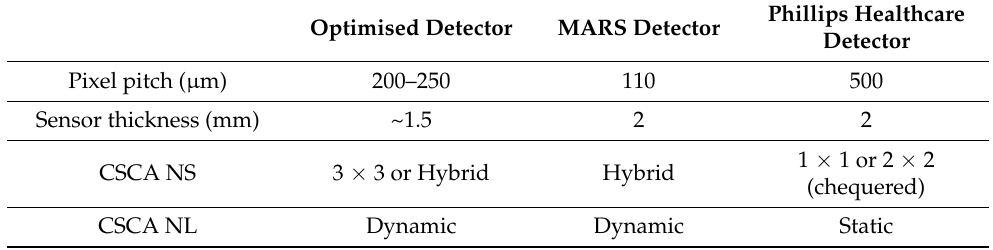
Table 2. Comparison of values for several key design parameters, as used in leading detectors and a simulation-optimised system. Charge-sharing correction algorithm (CSCA) parameters of neighbourhood size (NS) and neighbourhood location (NL) are looked at here and defined in other publications